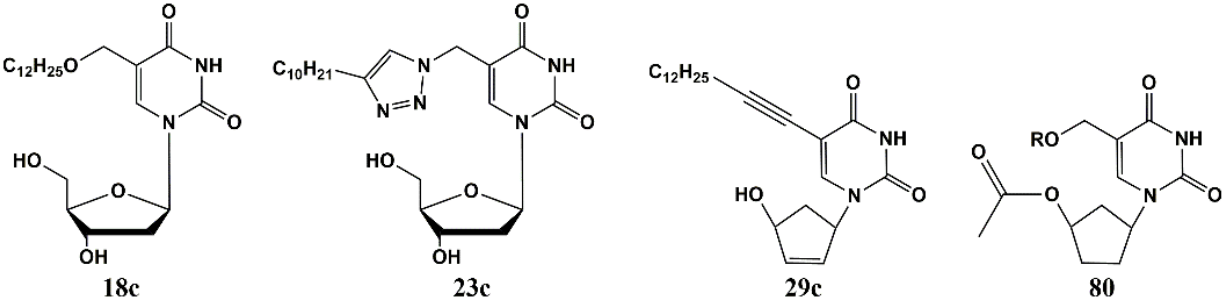
Figure 23. Structures of 5-substituted uracil derivatives, effective inhibitors of Mtb growth.